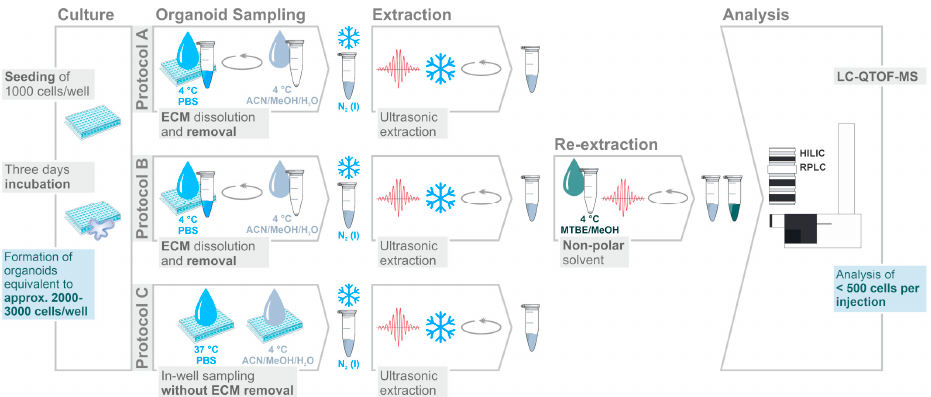
Figure 1. Extraction protocols evaluated for metabolomic and lipidomic profiling of colorectal cancer (CRC) organoids using LC-QTOF-MS after dual LC separation by HILIC and RPLC. The number of seeded cells/well was determined using an hemocytometer. Cell numbers after incubation were approximated based on the doubling time (3.4 days) as determined in concomitant experiments. Cell numbers for LC-MS analysis were calculated based on the solvent volumes used for sample preparation (optimized protocol C, see Supplementary Figure S7). Resulting extracts were dried and reconstituted in appropriate solvent prior to LC-QTOF-MS